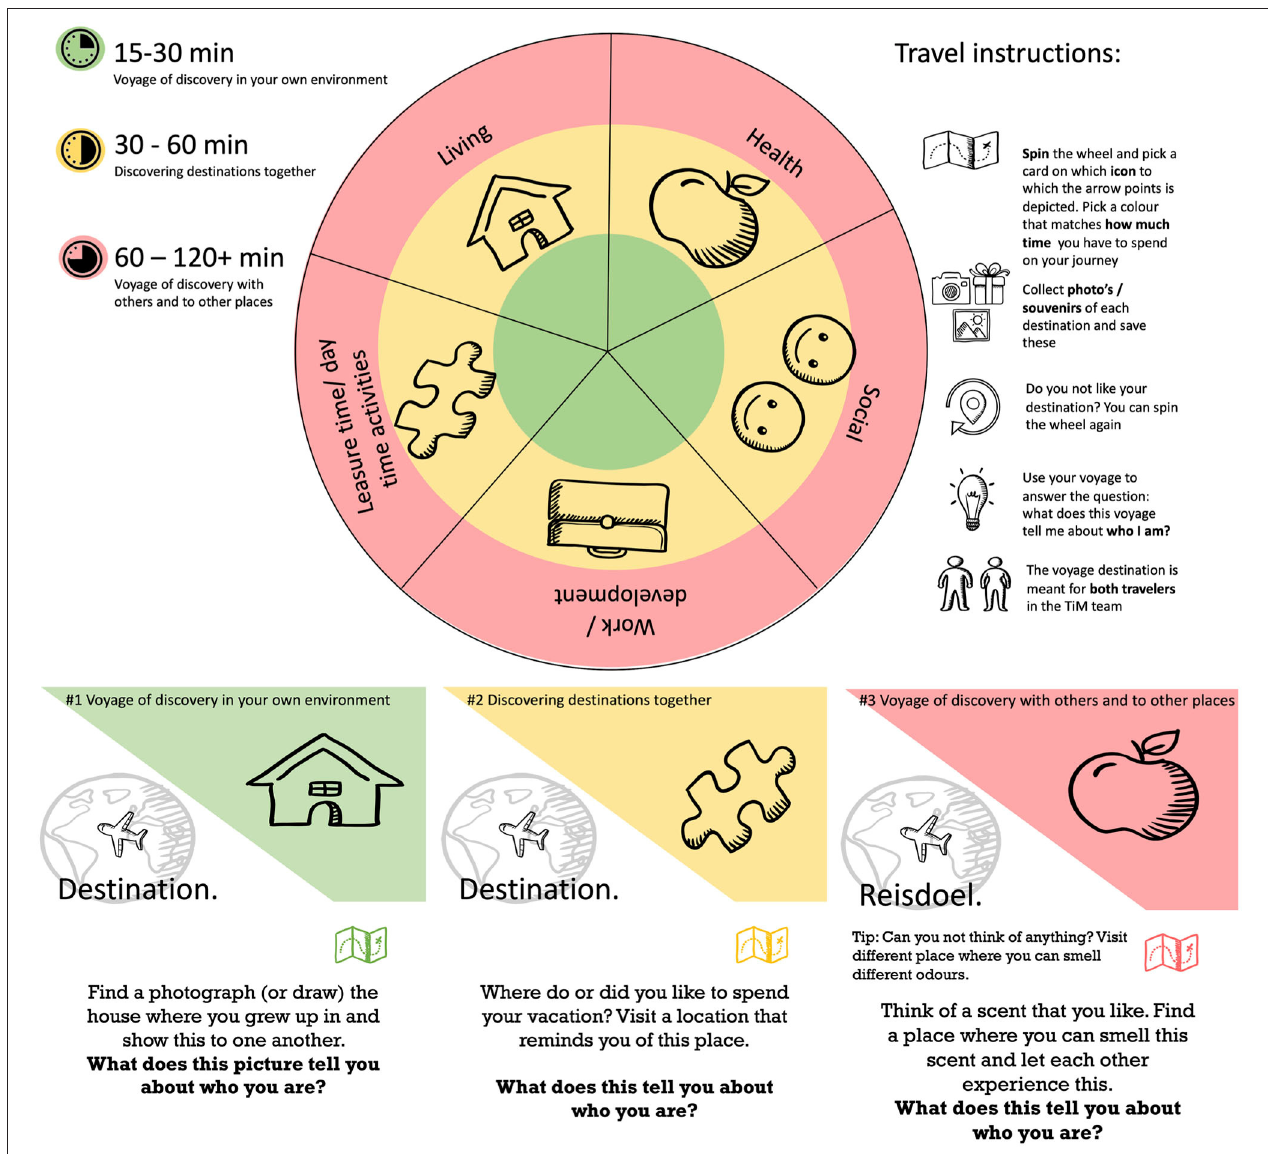
FIGURE 2 | Second